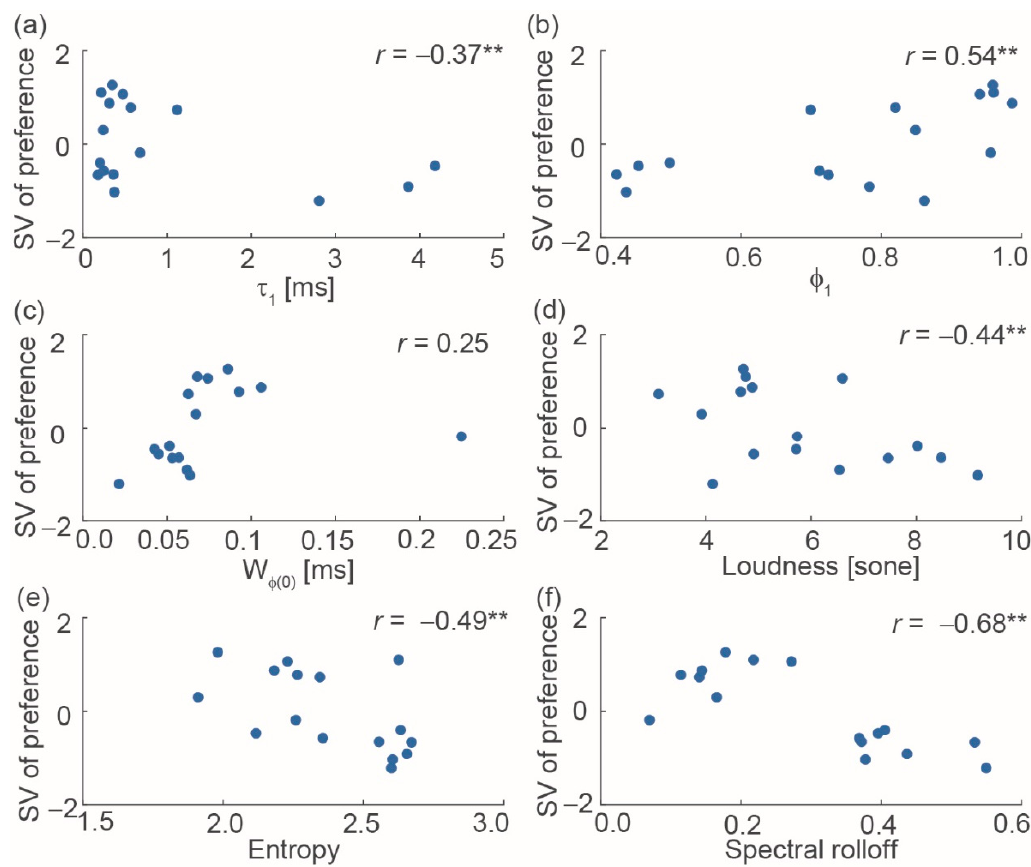
Figure 7. Relationships between physical parameters and scale values of preference for birdsong stimuli. ( a ) τ 1 , ( b ) φ 1 , ( c ) W φ (0) , ( d ) loudness, ( e ) entropy, and ( f ) spectral rolloff. The numbers represent